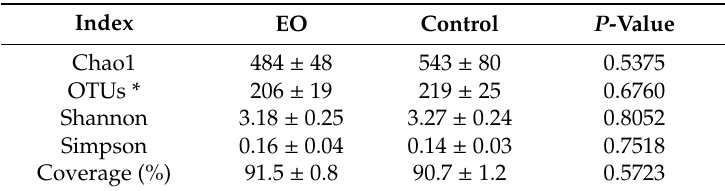
Table 2. Alpha diversity indices and coverage from ruminal bacterial communities of dairy calves fed an EO-supplemented or control diet. Values are presented as means and standard error of the mean, respectively.